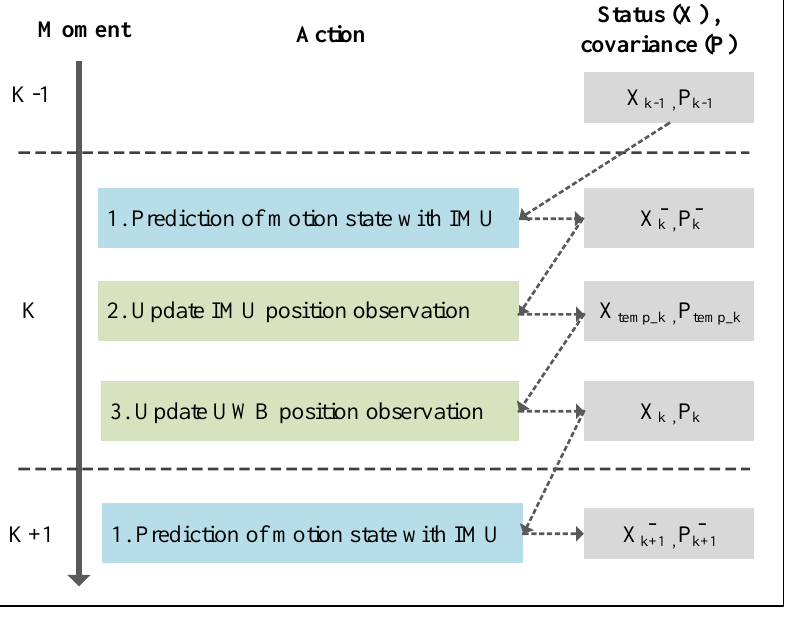
Figure 6. The data fusion process.